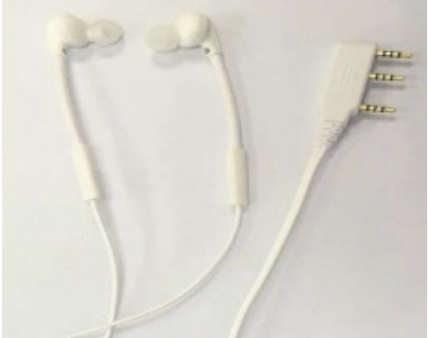
Figure 2: Bilateral earphone/microphone/inputcable configuration